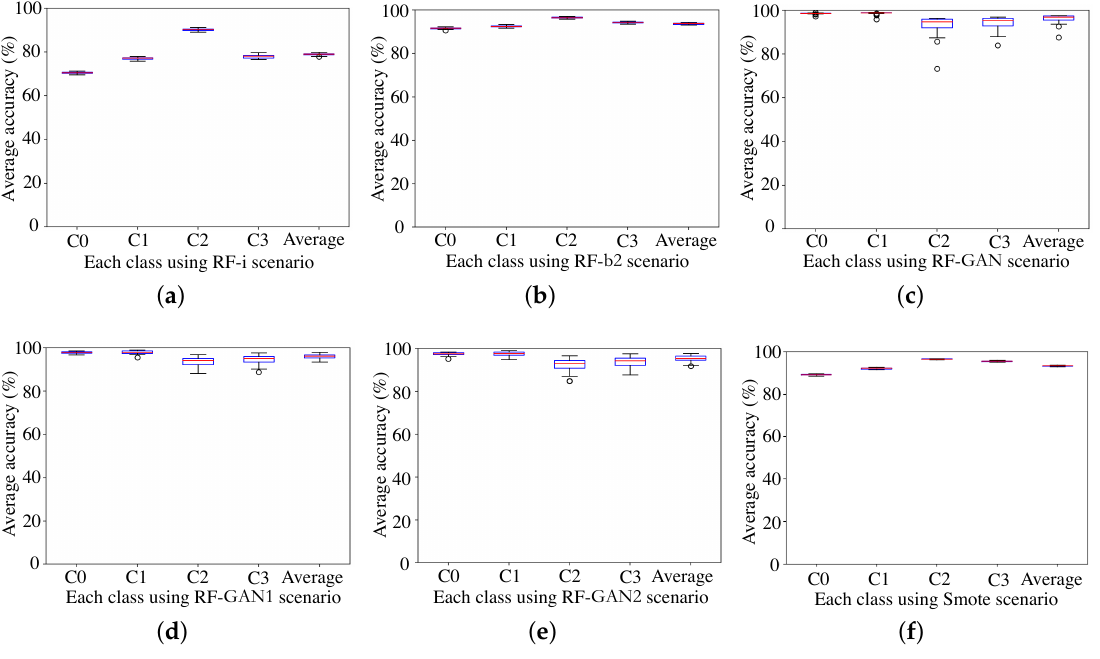
Figure 12. F1-score for scenario: ( a ) RF-i; and ( b ) RF-b2; ( c ) RF-GAN; ( d ) RF-GAN1; ( e ) RF-GAN2; and ( f ) SMOTE.